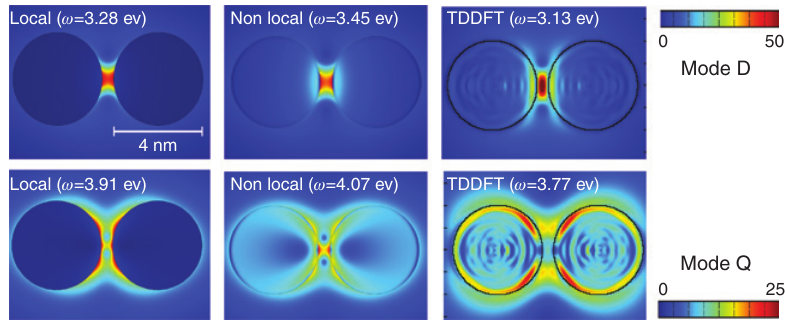
( r )|/| E | corresponding to the dipole (top line) and quadrupole (lower line) resonances of a Na nanowire dimer ( d = 2 nm). Figure 3: EFE | E tot ext The depicted E -fields have been obtained at the frequencies indicated in each panel. Figure adapted from Ref.